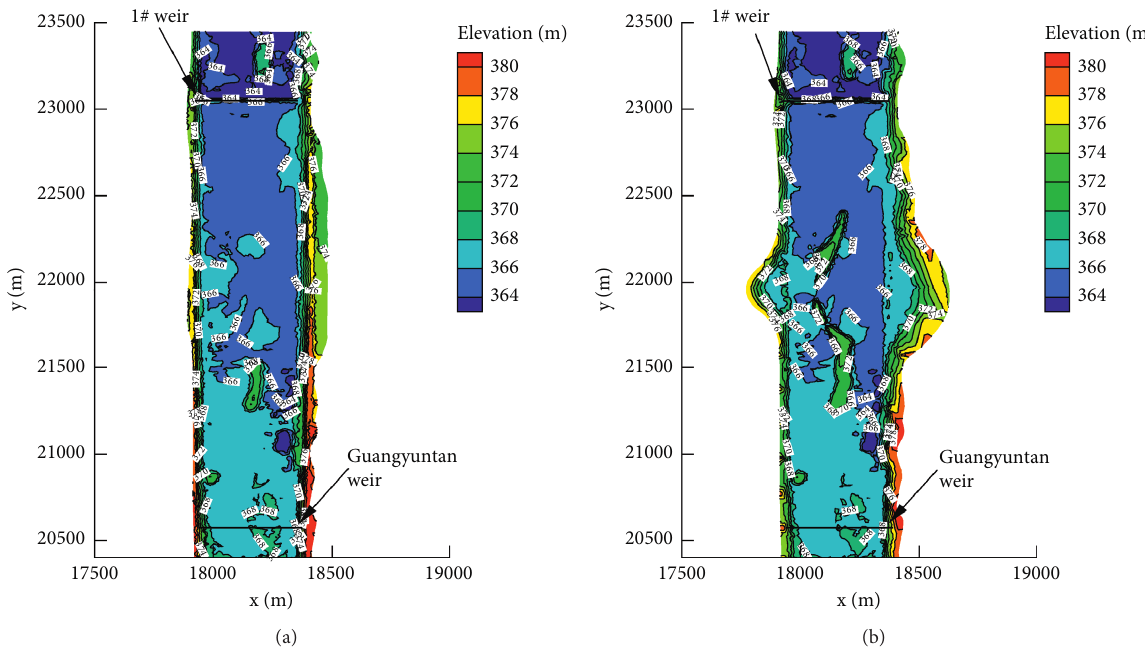
Figure 2: Topographies of the river channel. (a) Before reconstruction. (b) After